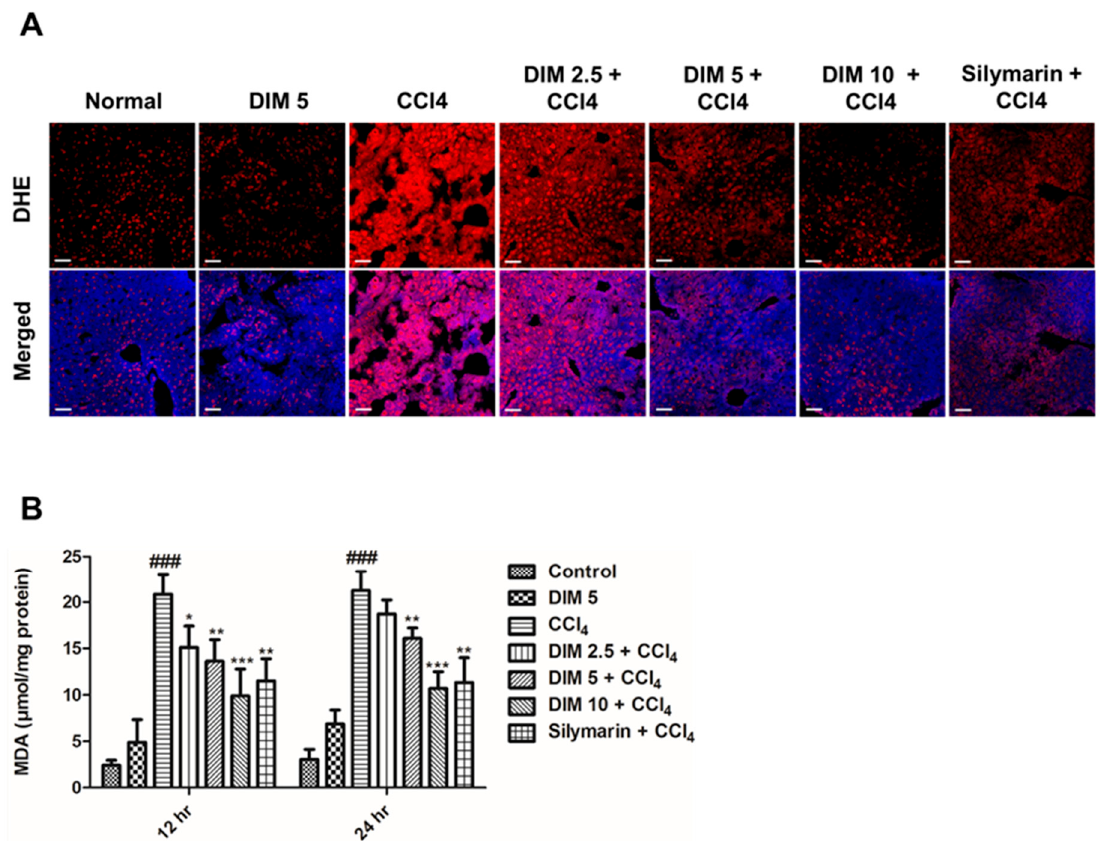
Figure 3. DIM pretreatment attenuates CCl 4 -induced oxidative stress and ROS production in mice. ( A ) Cryostat liver sections were treated with 5 μ M (DHE) dihydroethidium at 37 °C for 30 min, washed with PBS and mounted with DAPI and assessed using a confocal microscope. The scale bar represents 30 μ m. ( B ) MDA levels were measured using a commercial kit. Data are presented as mean ± SD ( n = 5). ### p < 0.001 determined as significant differences compared to the normal control group, * p < 0.05, ** p < 0.01, *** p < 0.001 compared to the CCl 4 group.